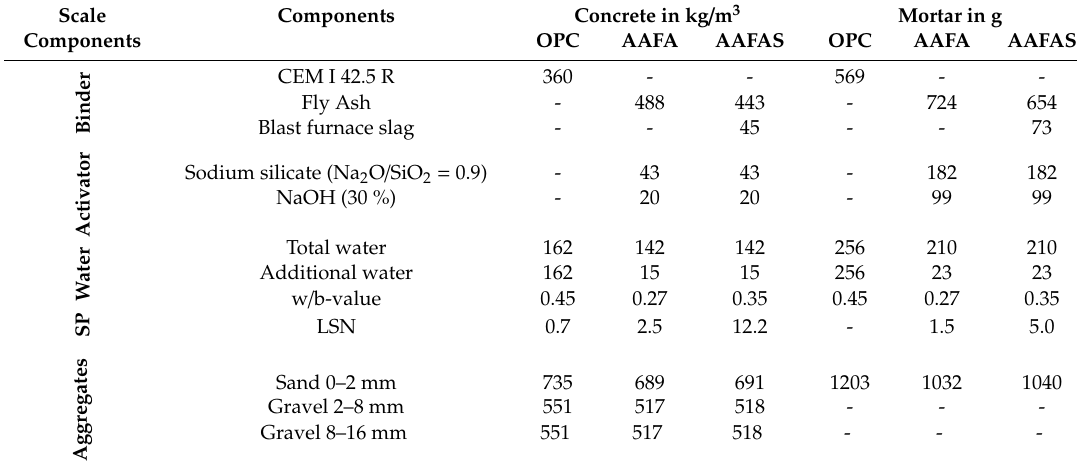
Table 2. Concrete mix design in kg / m 3 and mortar mix design in g. Abbreviations: AAFA, alkali-activated fly ashes; AAFAS, alkali-activated fly ashes with ten percentage mass (wt% of blast furnace slag; LSN, sodium